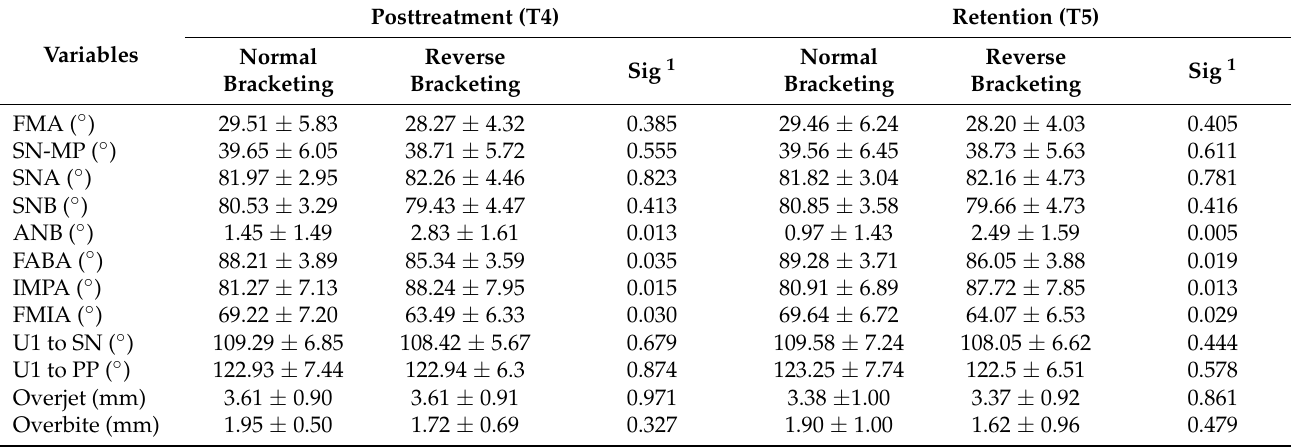
Table 3. Differences in dentoskeletal characteristics between the two groups at posttreatment and